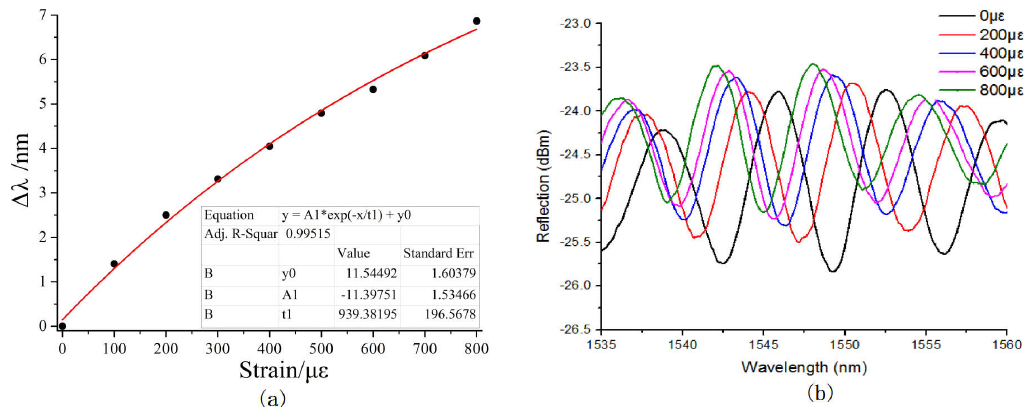
Figure 5. Strain sensitivity characteristics of proposed microbubble. ( a ) Wavelength shift of the interference fringe around 1555 nm as a function of tensile strain applied to the micro bubble; ( b ) Reflection spectrum evolution of the air bubble, while the tensile strain increases from 0 to 800 με .